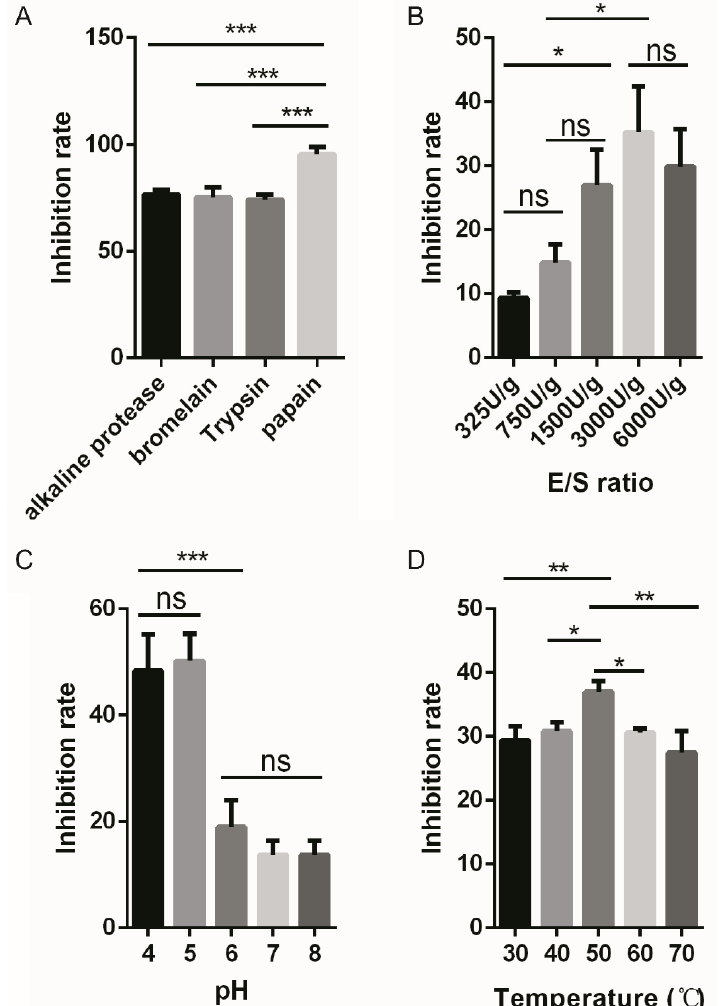
Figure 1. Protein hydrolysate of E. prolifera exhibit remarkable inhibition on cancer cell proliferation. ( A ) Hydrolysates generated using the indicated proteases showed differential anti-cancer activities. ( B – D ) Single factor experiments showed the impact of enzyme/substrate (E/S) ratio, pH, and temperature on the anti-proliferation property of hydrolysates generated by papain digestion, respectively. * p < 0.05, ** p < 0.01, *** p < 0.001 and ns, not significant (n = 3).